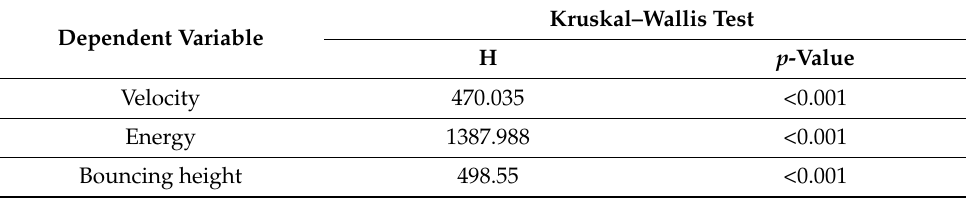
Table 3. Dunn’s (Post Hoc) test